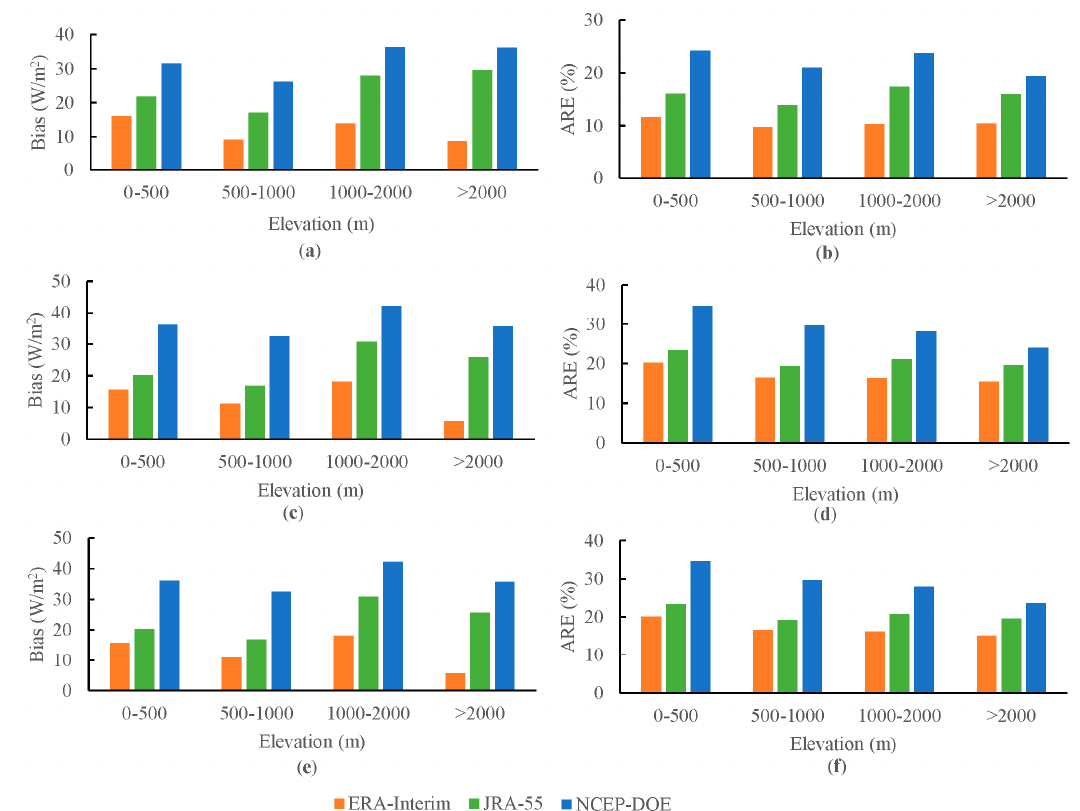
Figure 4. Evaluation results of the annual, seasonal, and monthly solar radiation from three reanalysis datasets across all percentiles at different elevations (unit of bias: W/m 2 , ARE: %): ( a ) Bias of annual solar radiation; ( b ) ARE of annual solar radiation; ( c ) Bias of monthly mean solar radiation; ( d ) ARE of monthly mean solar radiation; ( e ) Bias of seasonal mean solar radiation; ( f ) ARE of seasonal mean solar radiation.